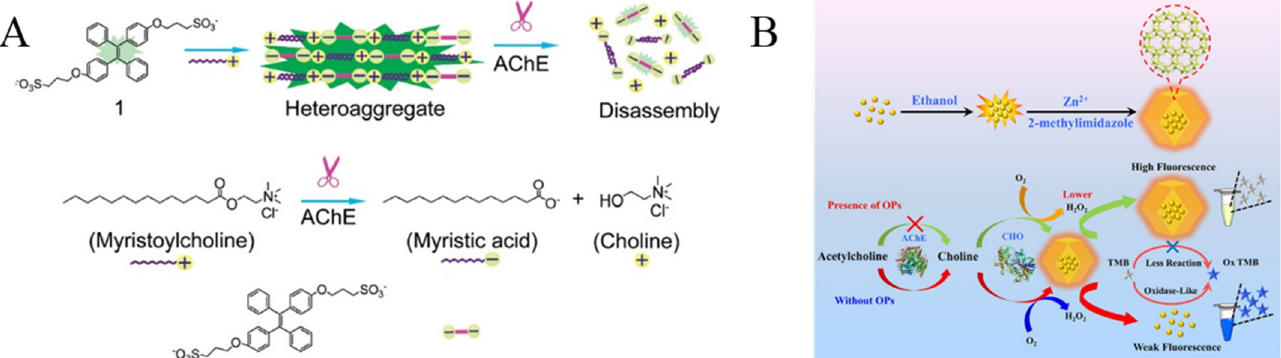
Figure 10. ( A ) Illustration of the formation of heteroaggregate between myristoylcholine and tetraphenylethylene 1 and the disassembly of the aggregate in the presence of AChE. Reprinted with permission from ref. [89]. Copyright 2009, American Chemical Society. ( B ) Schematic diagram of the mechanism for the detection of OPs. Reprinted with permission from ref. [93]. Copyright 2021, American Chemical Society.